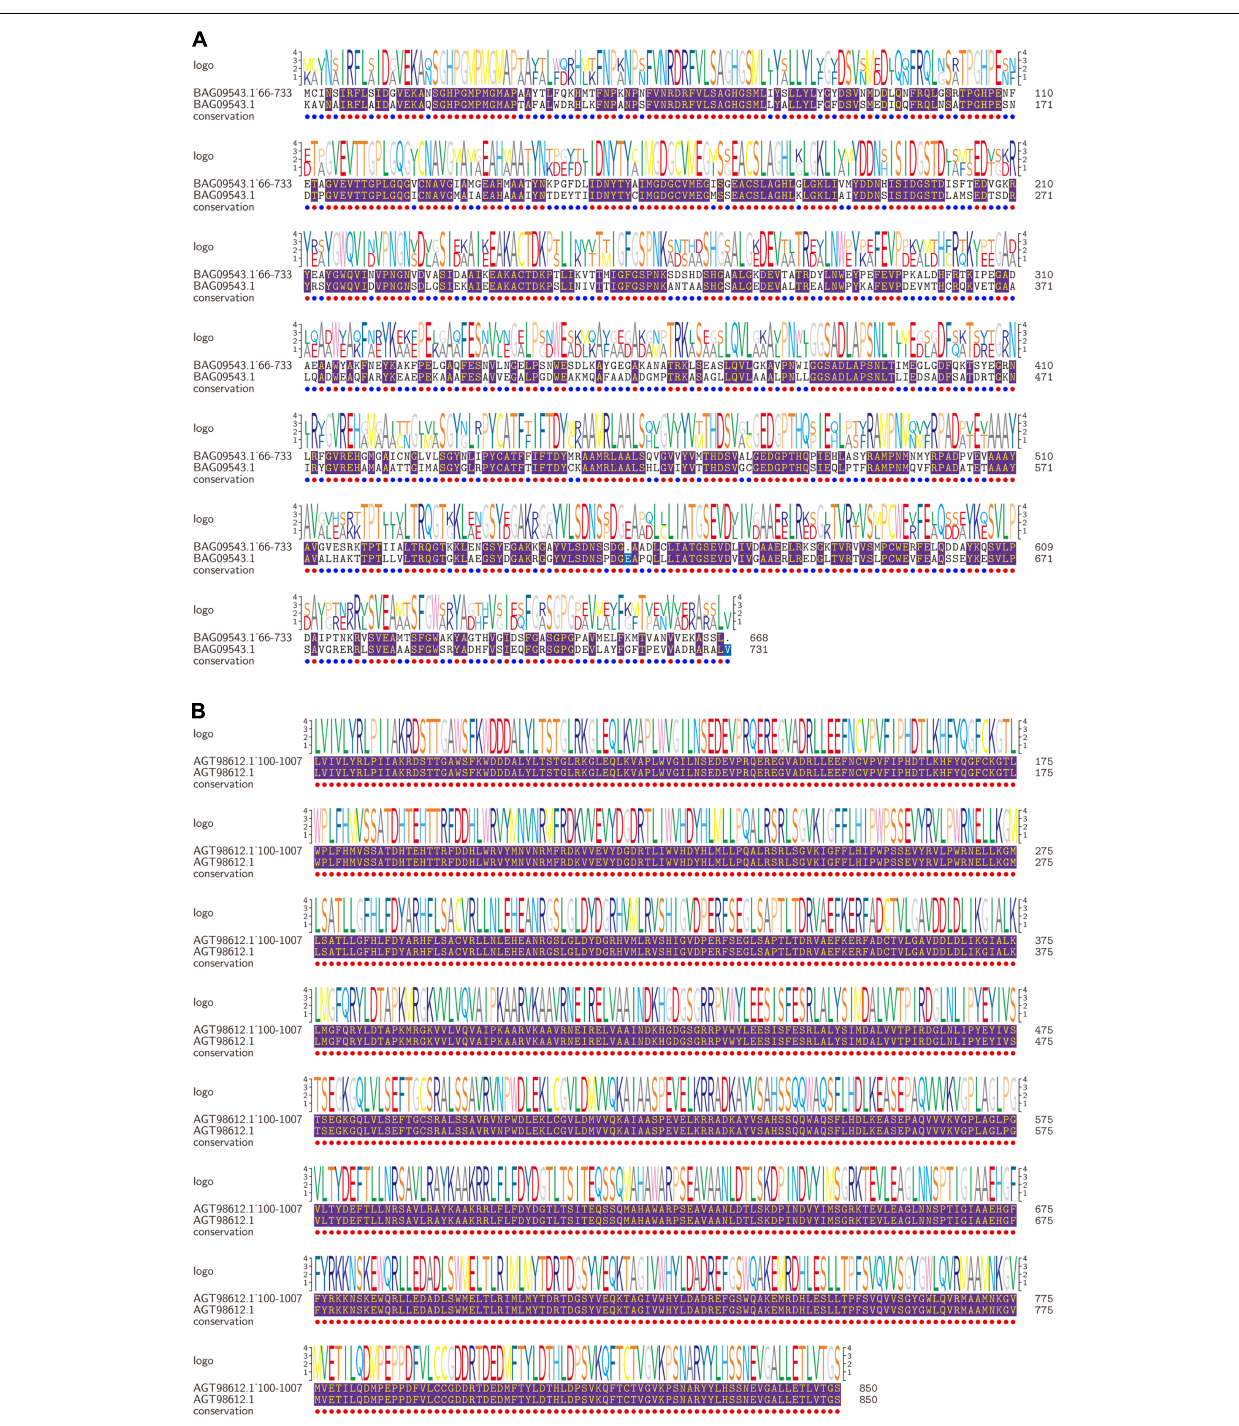
drug treatment of brucellosis (39). Therefore, we identified a potential pepsin/trypsin digest of peptides (GGPGGRFF, MAMAFALAACGKVGVDICDPGCTAK) that may be used